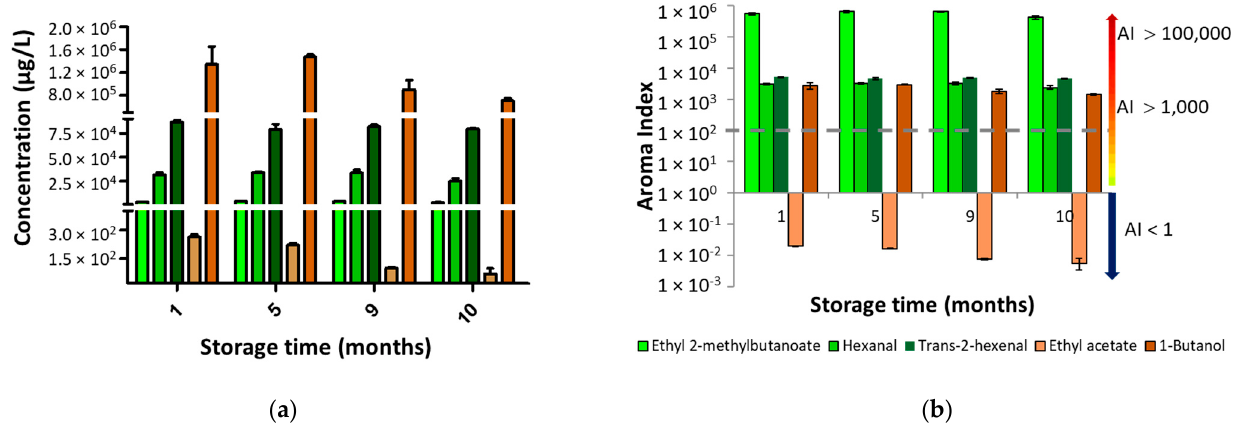
Figure 2. Quality assessment of key compounds monitored during apple aroma storage at room temperature, produced in January, from apples harvested in 2013. ( a ) Concentration in µg/L of each compound; ( b ) Aroma Index (AI) calculated for each compound using the odor thresholds reported in literature. The standard deviation was represented as error bars.